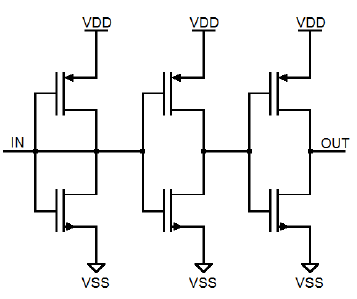
Figure 2. Circuit that implements the activation function of the neuron